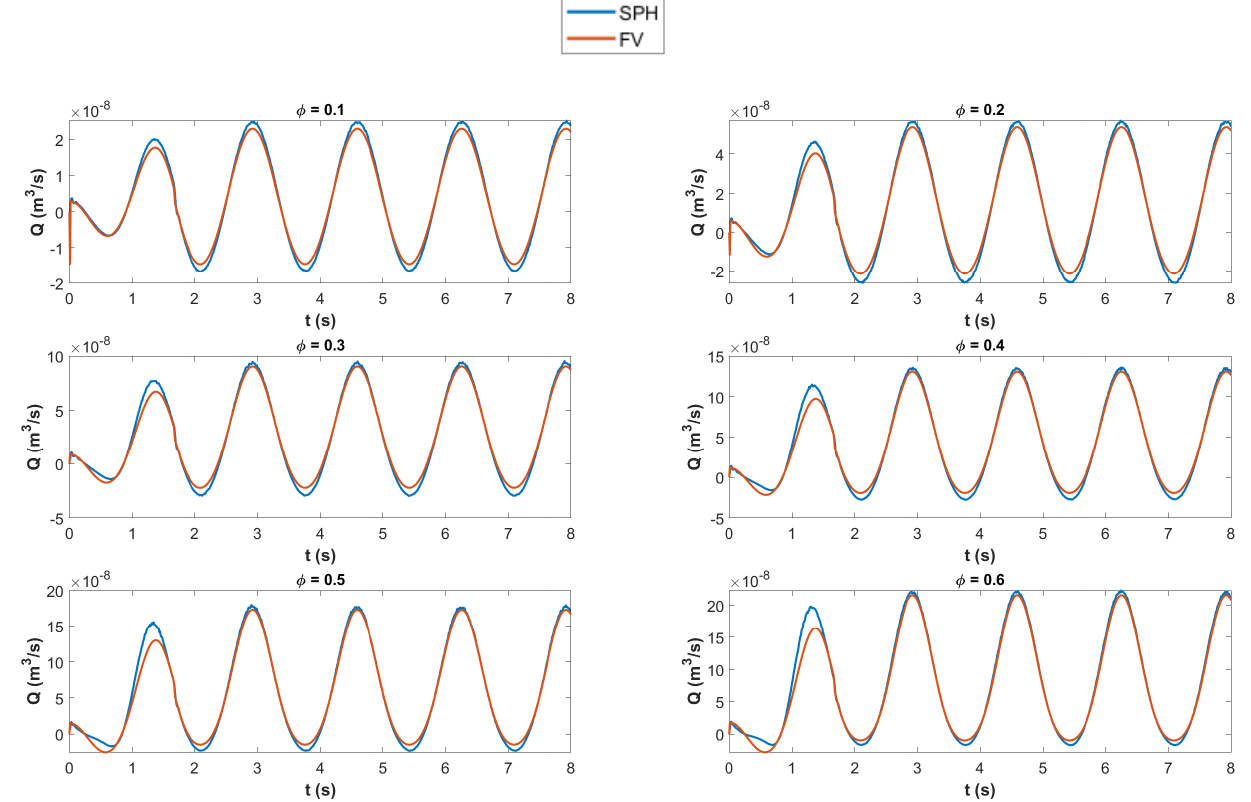
Figure 9. Volumetric flow rate at the mid cross-section over time from both models. The dimensionless time-averaged volumetric flow ( 𝑉 ∗ ) recorded from both models is then calculated based on the time–mean volumetric flow rate ( 𝑄(cid:3364) ).